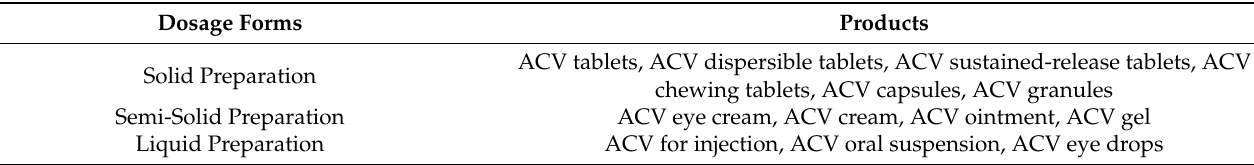
Table 2. Currently available dosage